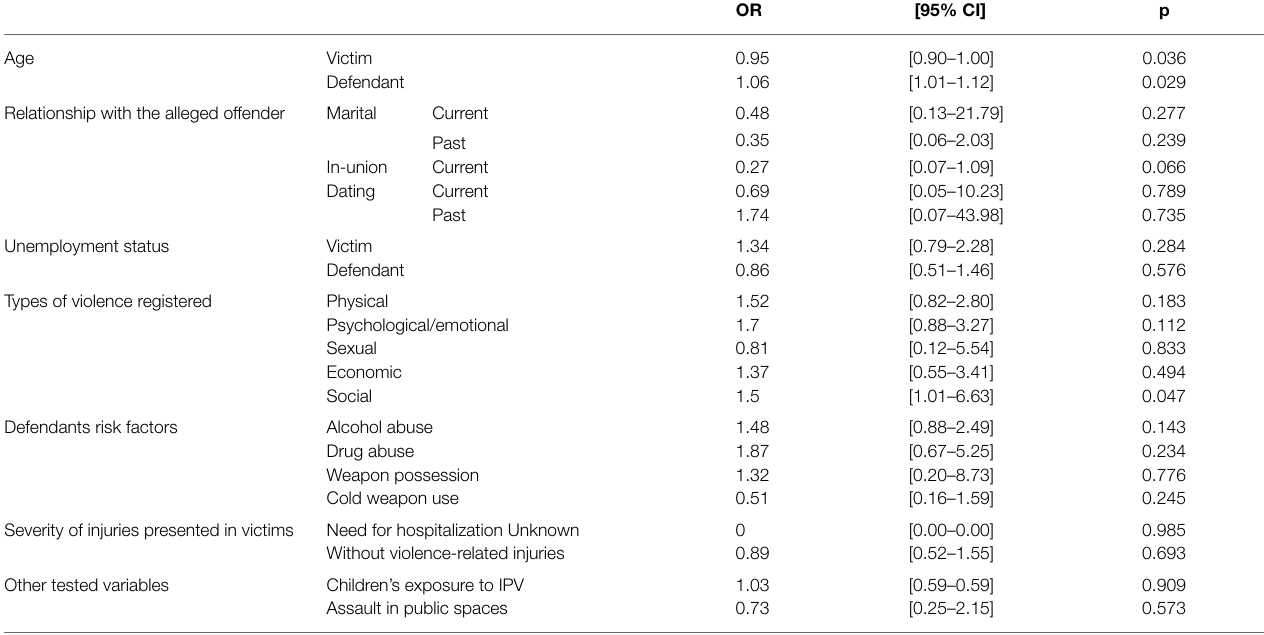
TABLE 4 | PSCP determinants.